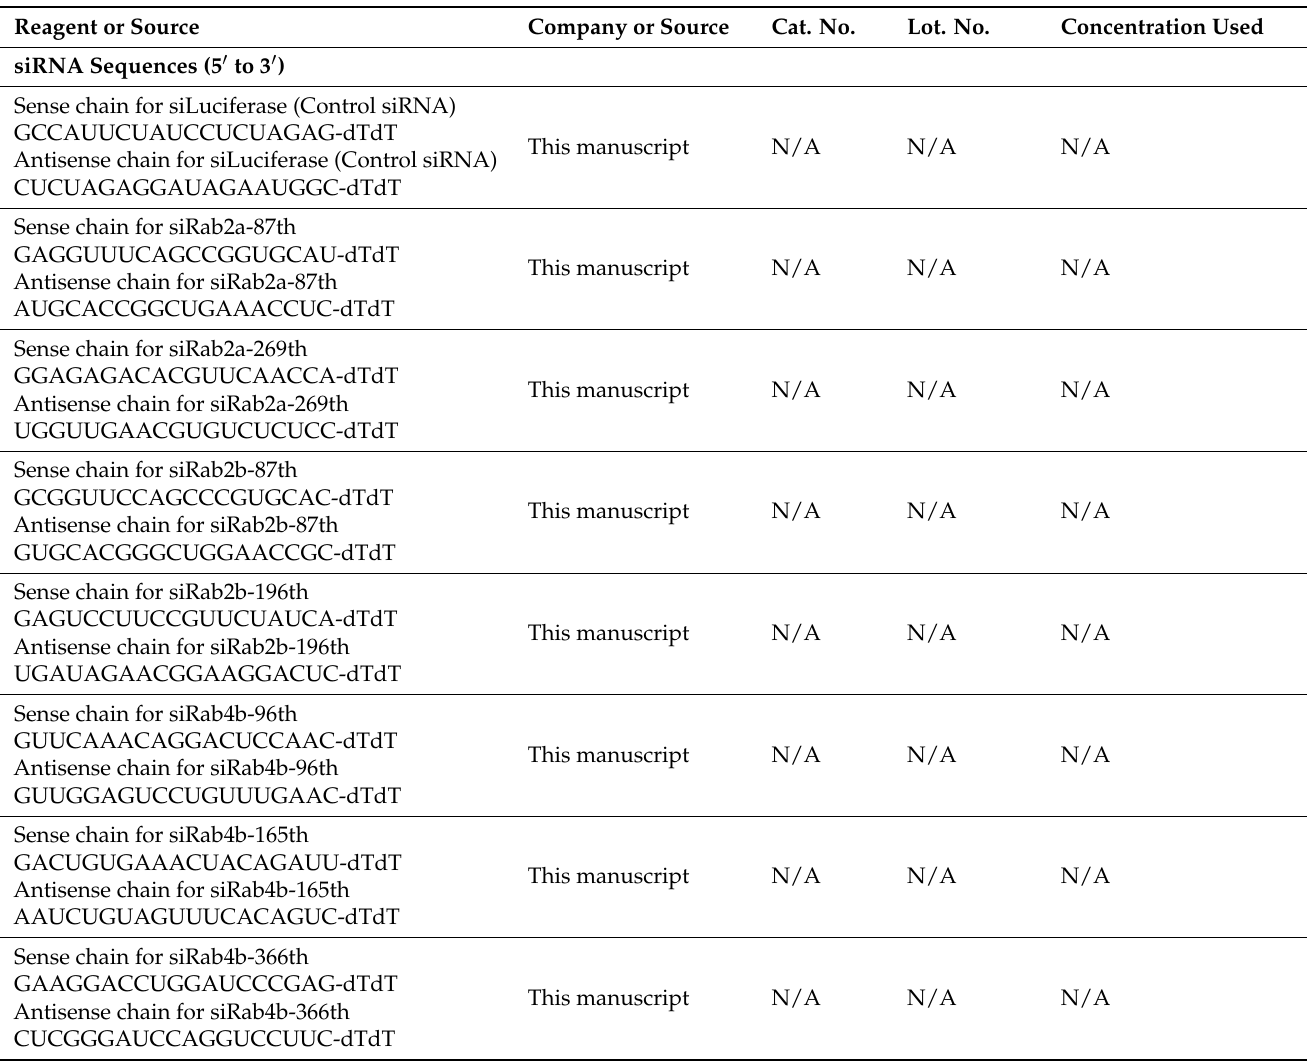
Table 6. List of